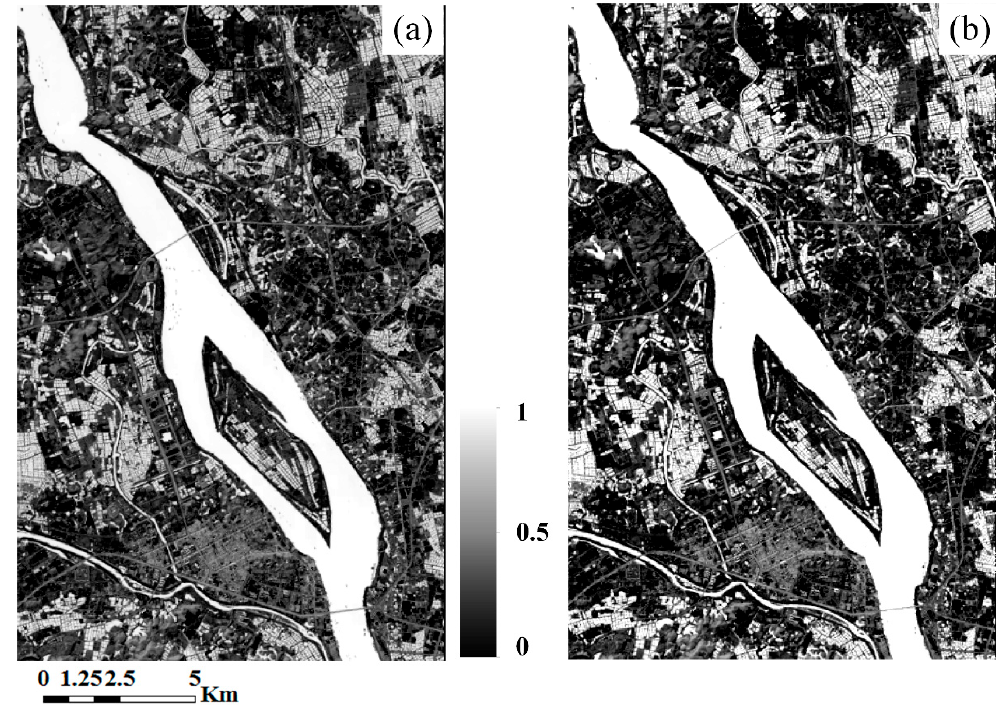
Figure 9. Surface water fractions of Region B extracted by the: ( a ) conventional; and ( b ) modified linear spectral mixture analysis (LSMA) methods.